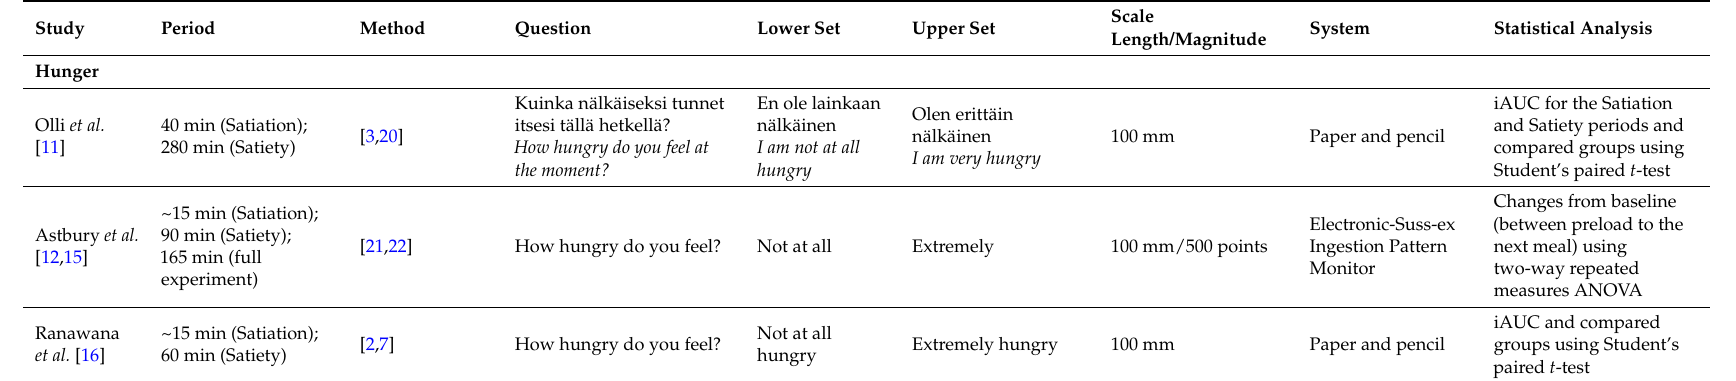
Table 2. Characteristics of the methodologies to measure subjective feelings of appetite used in the studies selected for this